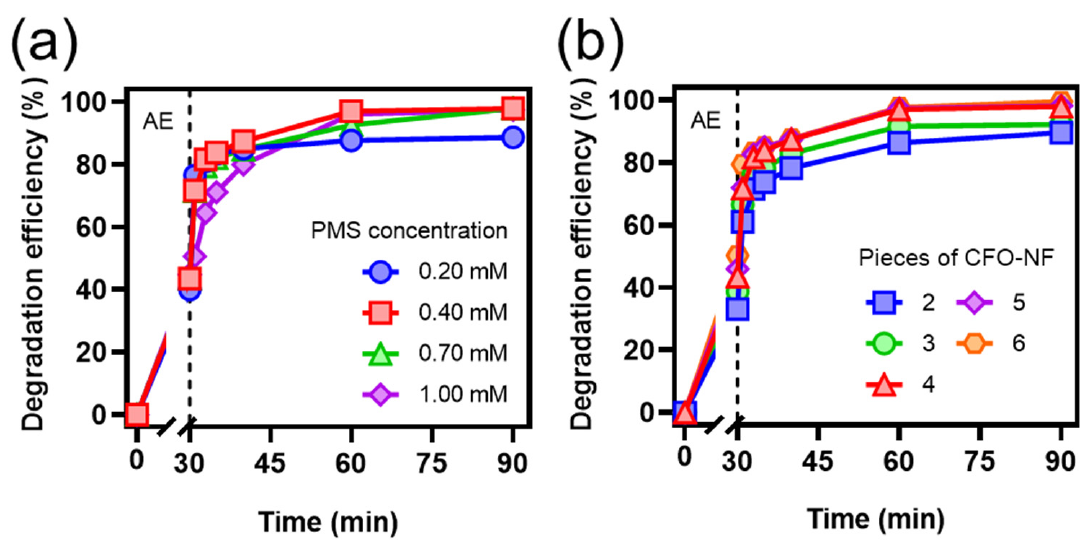
Figure 4. Effect of ( a ) PMS concentration (TC: 10 mg L − 1 , catalysts: 4 pieces, 25 °C), and ( b ) the amount of CFO-NF (TC: 10 mg L − 1 , PMS: 0.4 mM, 25 °C) on TC degradation efficiency (Note: AE represents adsorption equilibrium).